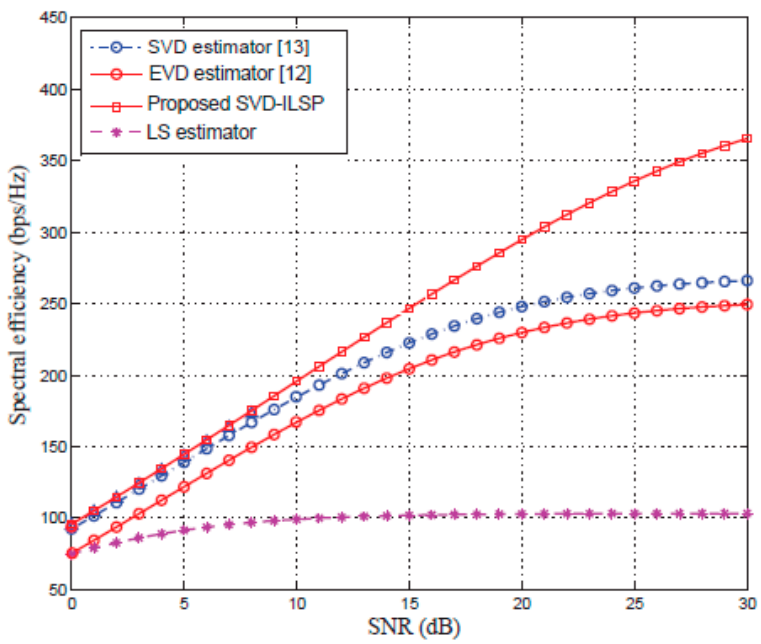
Figure 6. Spectral efficiency comparison of algorithms under different SNR conditions.